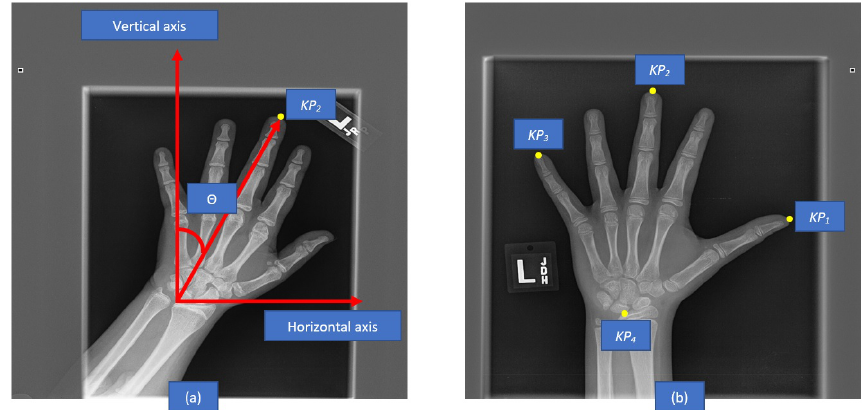
Figure 5. ( a ) shows the angle theta used for the rotation operation and ( b ) shows the four keypoints used in training the